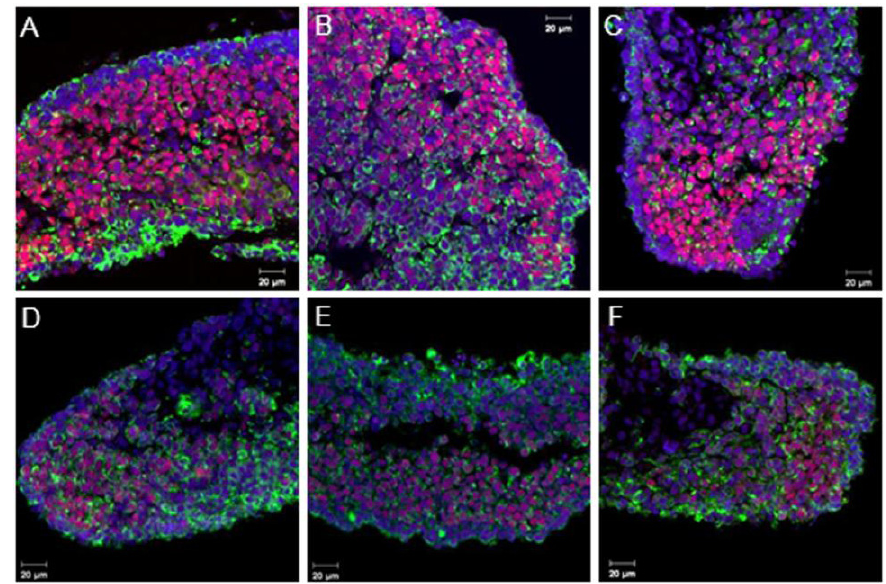
Figure 2. Double immunofluorescence of SOX9 (red) and cytokeratin (green) in gonads from L. olivacea cultured with ( A ) Opti-MEM, CO, ( B ) Lipofectamin and Opti-MEM, CL, ( C ) transfected with the scrambled control sequence, CS, and ( D (cid:177) F ) transfected with 100, 300 and 600 pmol of siRNA, respectively. Scale bar = 20 µm.